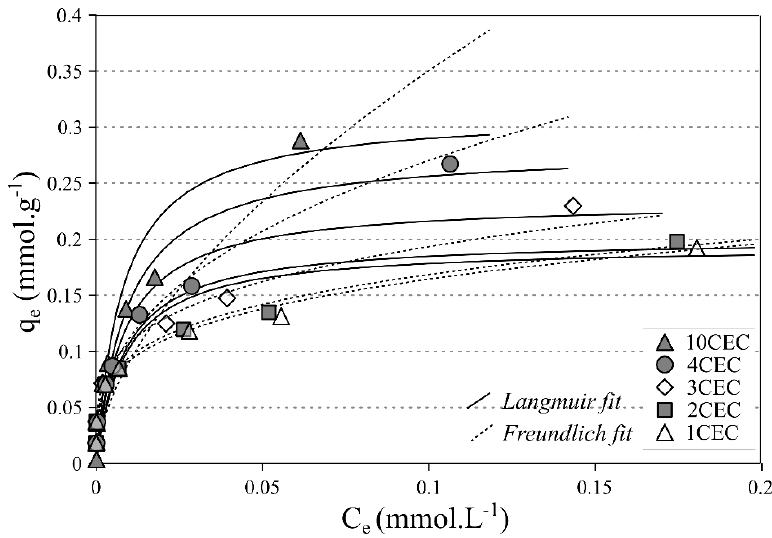
Figure 7. Single-solute adsorption isotherms at 293 K of Sr 2+ onto LAP-APTES for different loads of APTES (pH = 6–6.5).